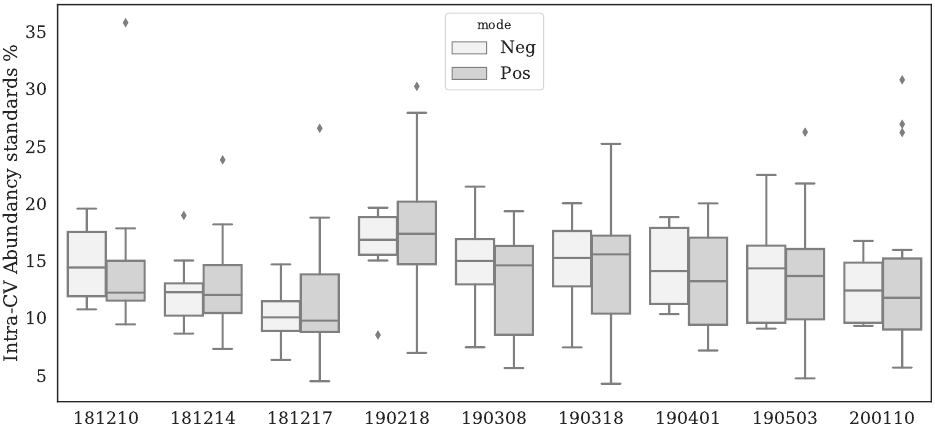
Figure A1. Boxplots per batch and ion mode for intra-batch Coefficients of Variation (CV) for all standards. Area’s were determined by using Xcalibur